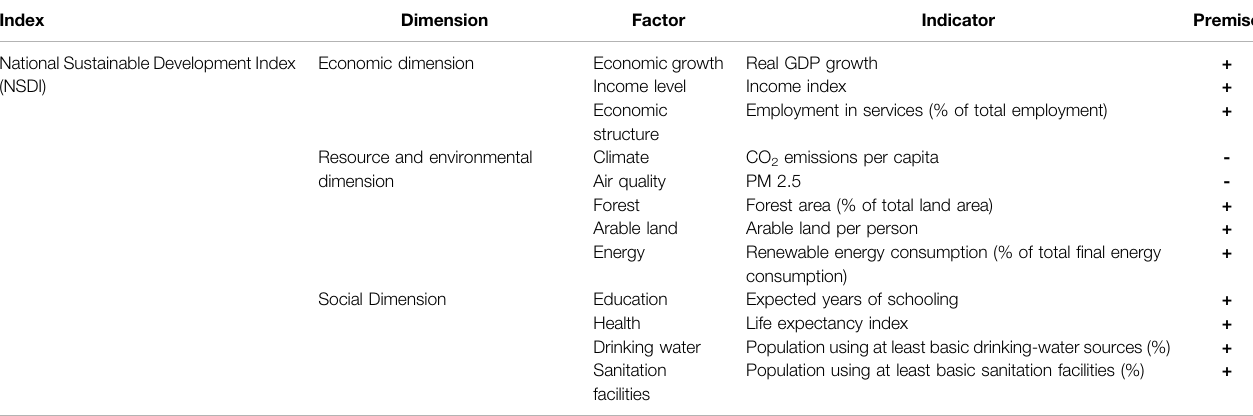
TABLE 1 | Framework of National Sustainable Development Index.